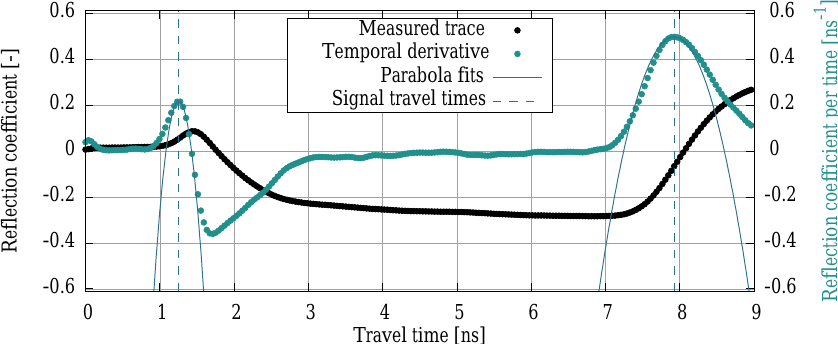
Figure A1. The evaluation of a TDR trace is based on the detection of the inflection points caused by the probe head and the end of the rod. This is done automatically after calculating of the first temporal derivative of the trace. Parabolas are fitted to the maxima of the temporal derivative to increase the precision of the evaluated signal travel